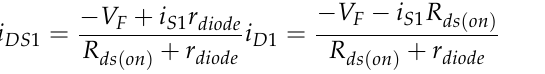
Figure 4. Current waveforms of S1, D1, S4, and D4 in Figure 3a, obtained by MATLAB/Simulink when the traction inverter is supplied with 750 V DC and applies 480 V l-to-l at 60 Hz to the stator. ( a , b ) Si-IGBT-based converter supplies 173 kVA at 0.81 pf; ( c , d ) SiC power MOSFET-based converter supplies 173 kVA at 0.81 pf, and ( e , f ) SiC power MOSFET-based converter supplies 75 kVA at 0.29 pf.